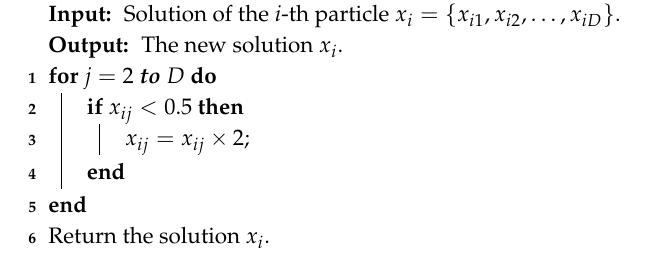
Algorithm 3: Increasing probability operator